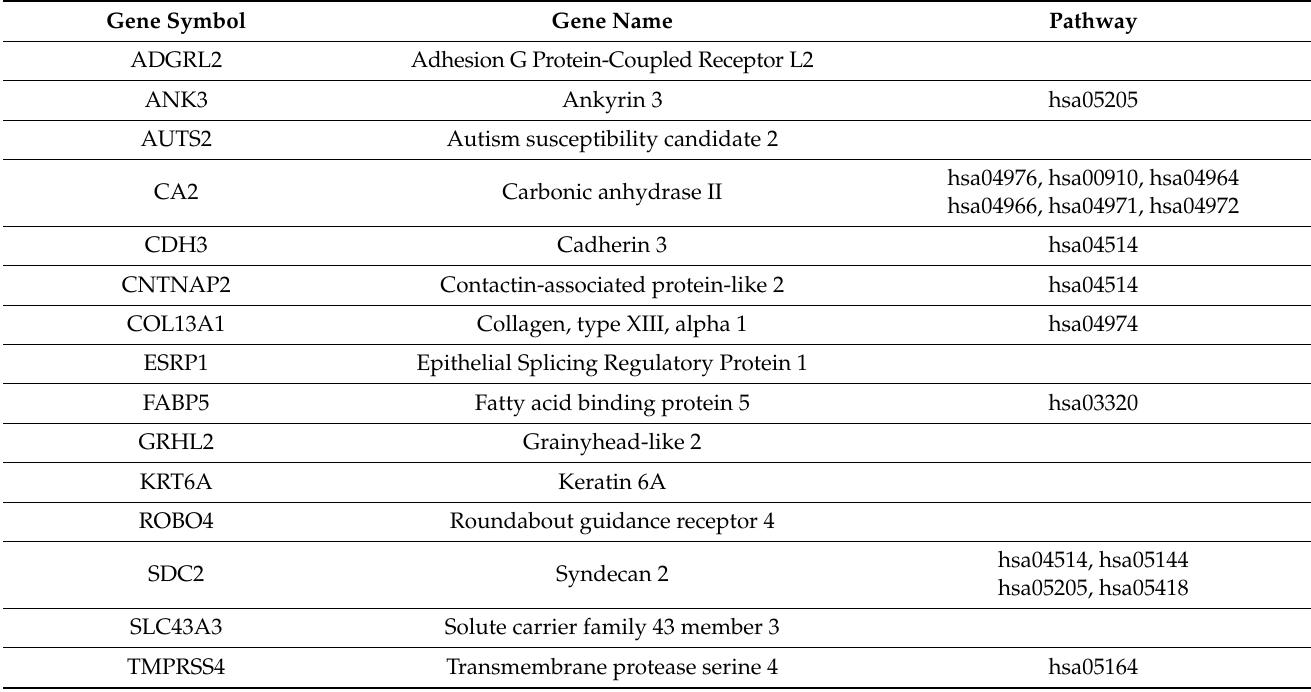
Table 5. List of 16 genes from the Venn diagram.